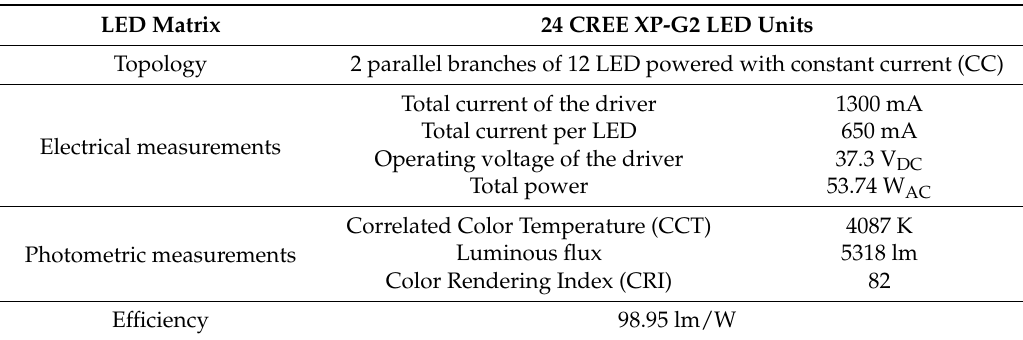
Table 3. Characteristics of the LED matrix used for the tests in this